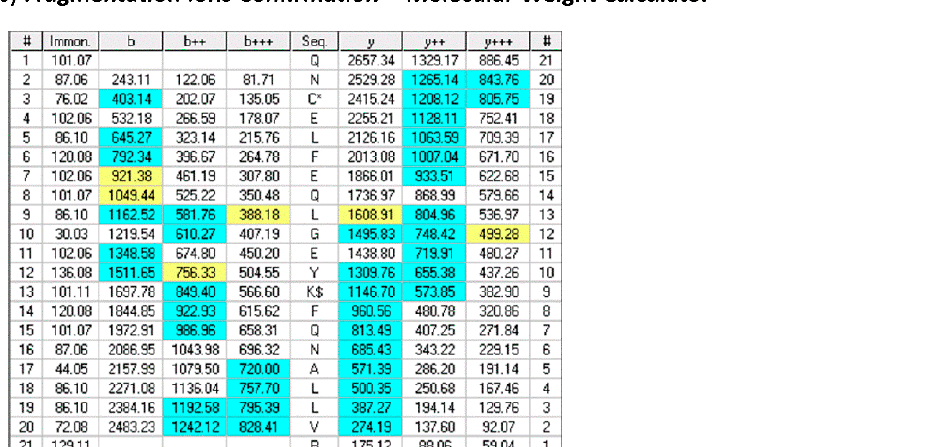
Figure 4. Experimental MS 2 spectra acquired in a targeted way corresponding to the CML-Lys 402 ( panel a ), and the corresponding theoretical fragmentation pattern obtained by means of Molecular Weight Calculator software ( panel b ). (*modified fragment ion)